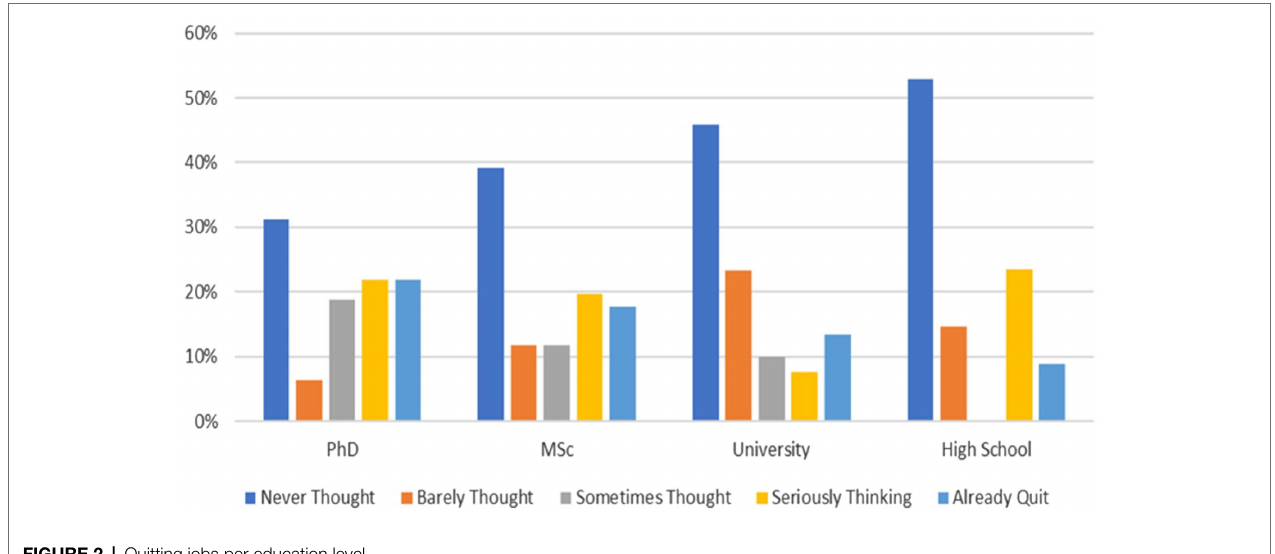
FIGURE 2 | Quitting jobs per education